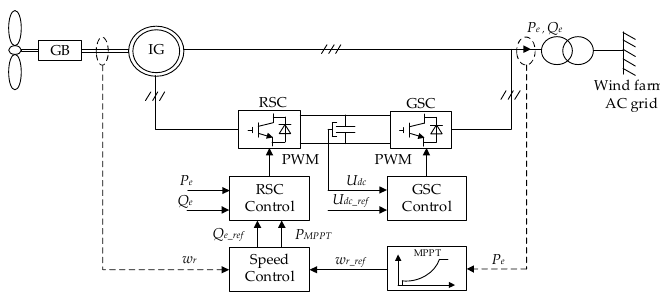
Figure 2. The structure diagram of the grid-connected DFIG.